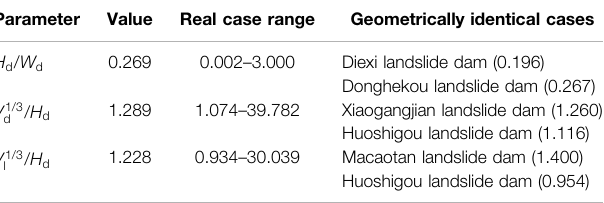
TABLE 2 | Geometric characteristics of the model landslide dams.